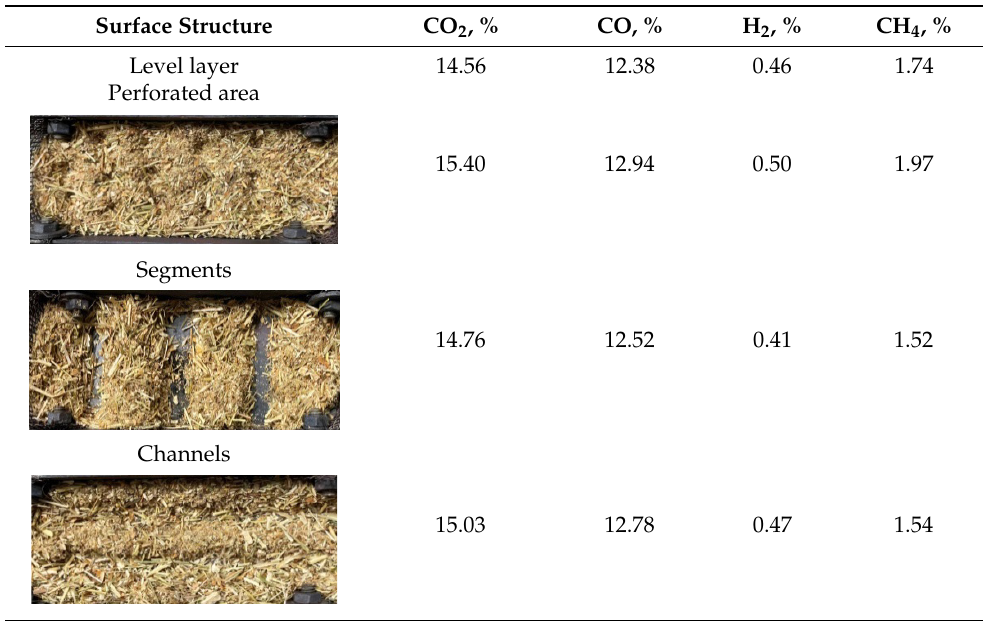
Table 7. Gas component concentrations in the pyrolysis of biomass (sawdust 25%, straw 50%, leaves 25%) with different surface structures at a pyrolysis temperature of 500 °C.